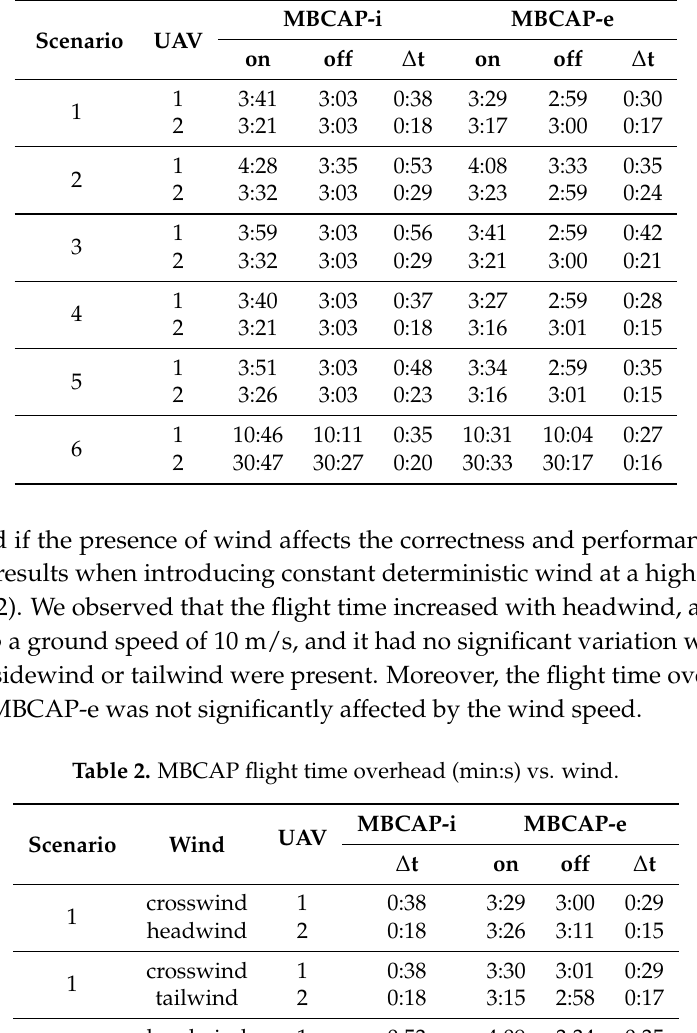
Table 1. MBCAP flight time overhead (min:s).